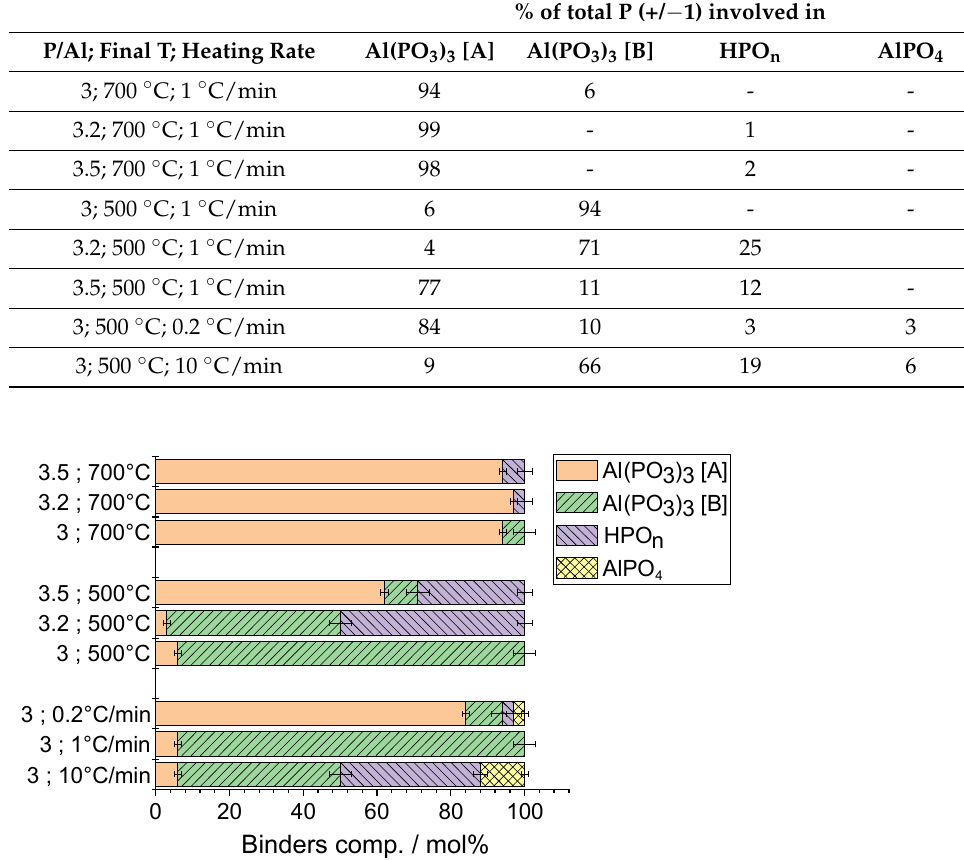
Figure 7. Binders compositions in mol% derived from the 31 P MAS-NMR spectra decompositions. Only compounds with relative proportion higher than 1% were taken into account, and only binders prepared with a dwell time of 1 h are reported. Errors on the mol% are estimated to +/− 3%. Table 5. Percentage of P signals deduced from the 31 P NMR spectra decompositions. Final T: final temperature. The errors on the quantification are +/− 1%. Only the data obtained on binders pre- pared with a dwell time of 1 h are reported here.